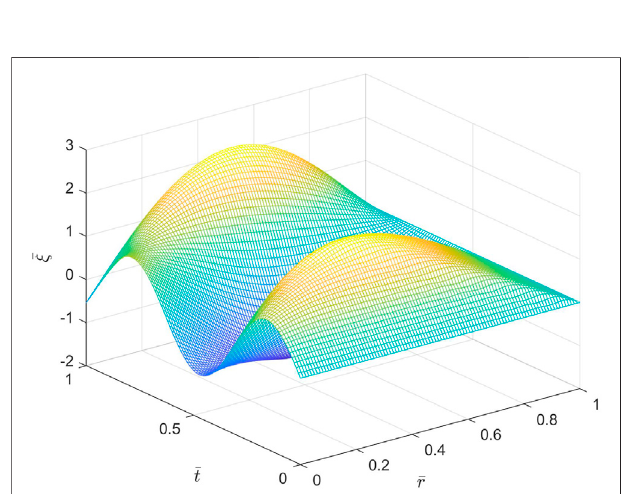
FIGURE 5 | Spatio-temporal variations of the dimensionless axial displacement (cid:2) ξ ( (cid:2) r , (cid:2) t ) for the variable fractional order α ( t ) corresponding to the case of dynamic NOS.